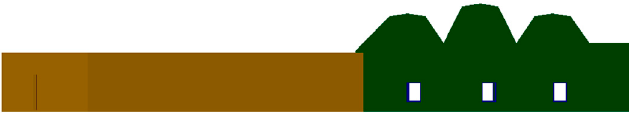
Figure 9. North elevation of Al Wafi Mosque.